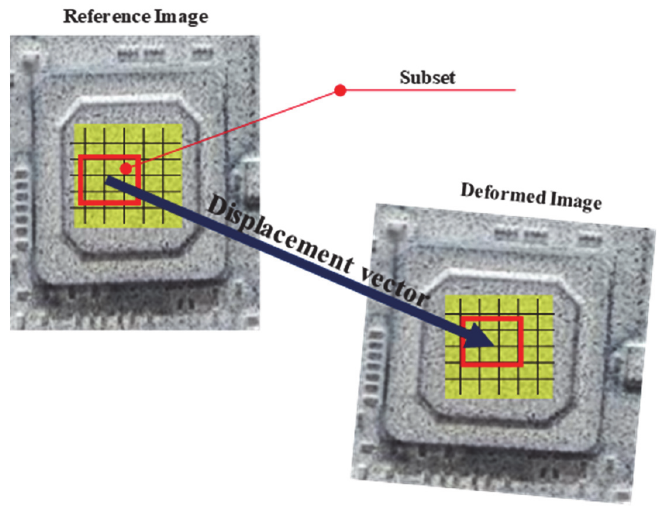
Figure 1: DIC basic